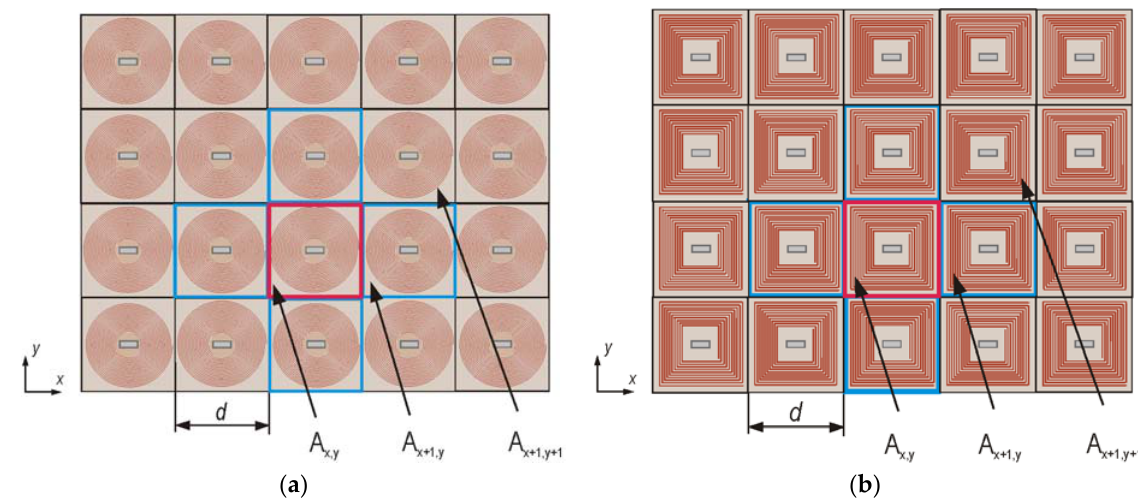
Figure 3. A two-dimensional fragment of the transmitting/receiving surface group of WPT system for the following: ( a ) circular coils (A x , y —the WPT cell) and ( b ) square coils.